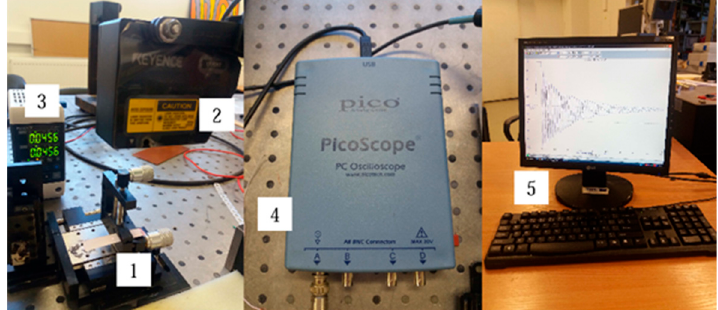
Figure 7. Experimental setup for determination of mechanical and electrical characteristics of the samples: 1, sample holder; 2, LK-G82 sensor head; 3, LK-G3001PV control block; 4, PicoScope oscilloscope; 5,